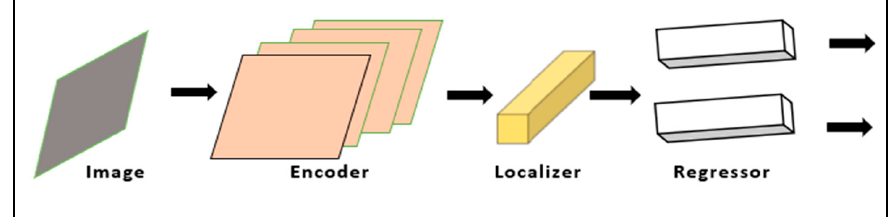
Figure 2. Pose-Net architecture.